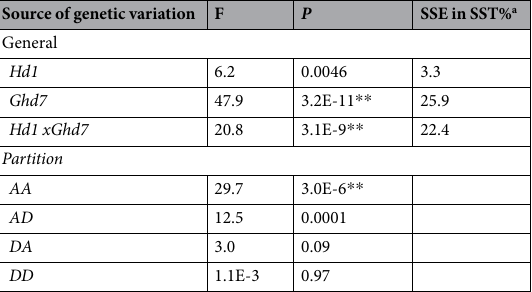
Source of genetic variation F P SSE in SST% a General